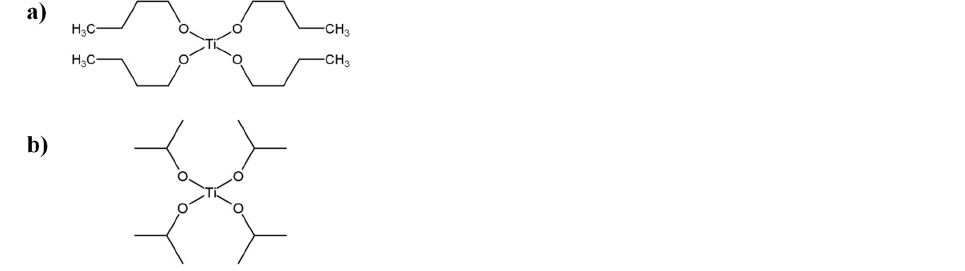
Figure 1. Chemical structures of 9 different catalysts employed in the transesterification step: ( a ) titanium (IV) butoxide (TNBT) and ( b ) titanium (IV) isopropoxide (TTIP).